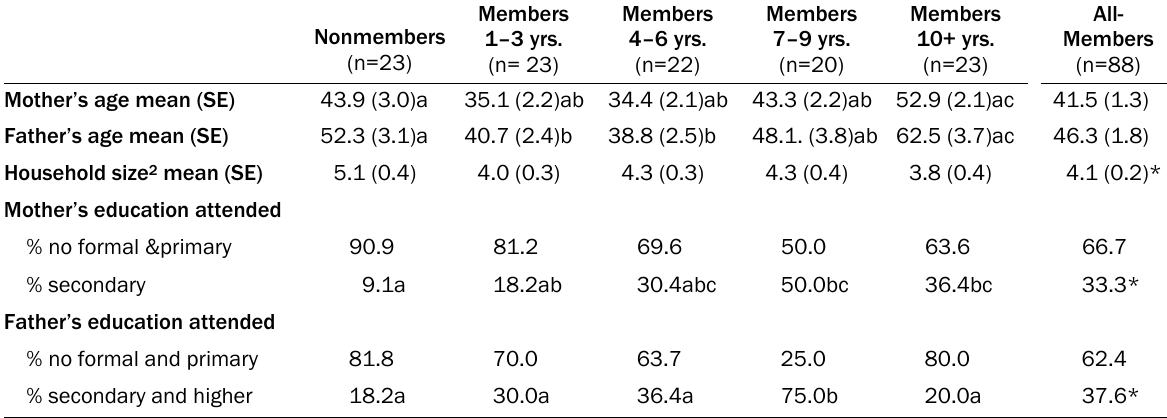
Table 1. Household Demographics, by Dairy Group Membership Duration